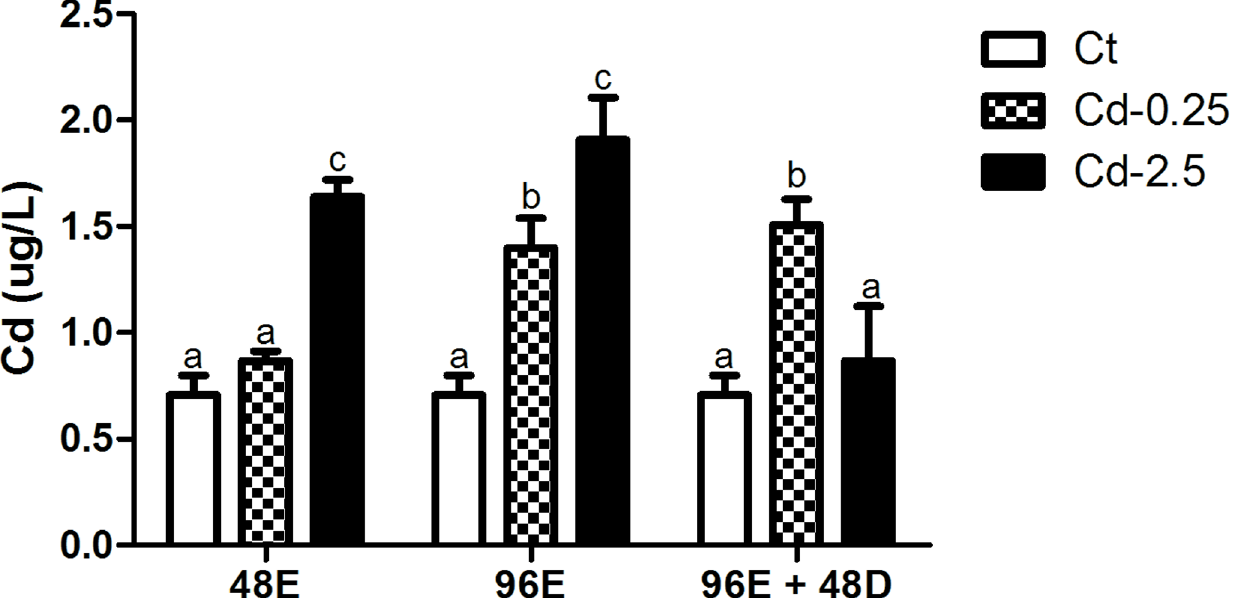
Fig 7. Concentration (means ± S.D.) of cadmium in blood obtained from animals of the in vivo assay. Values followed by different letters differ by ANOVA and Bonferroni tests (p <